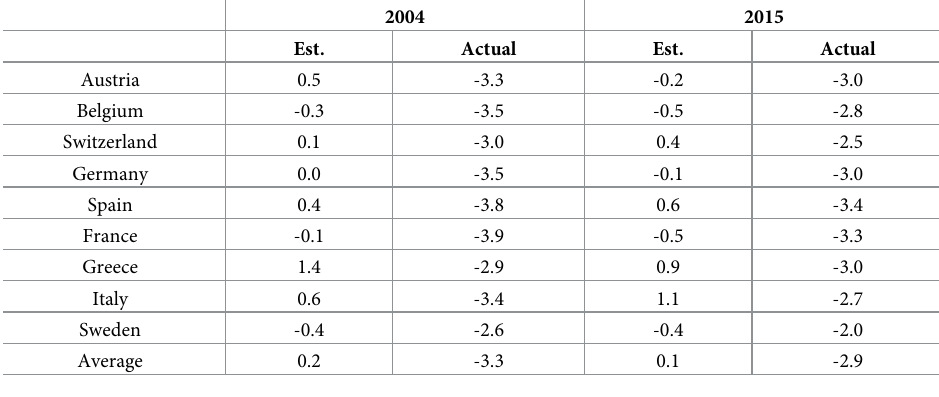
Table 6. Gender differences in estimated and actual life expectancy (men’s minus women’s), 2004 and